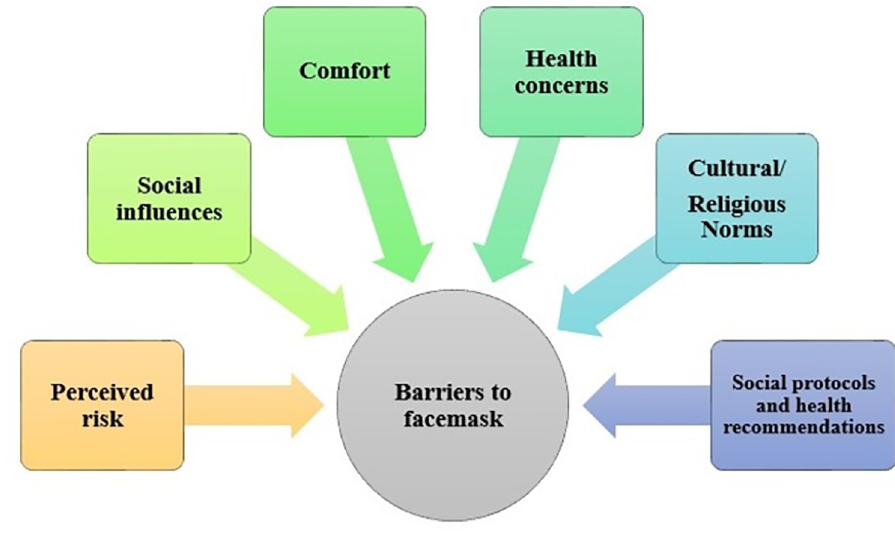
Fig 1. Conceptual framework for perceived barriers for facemask